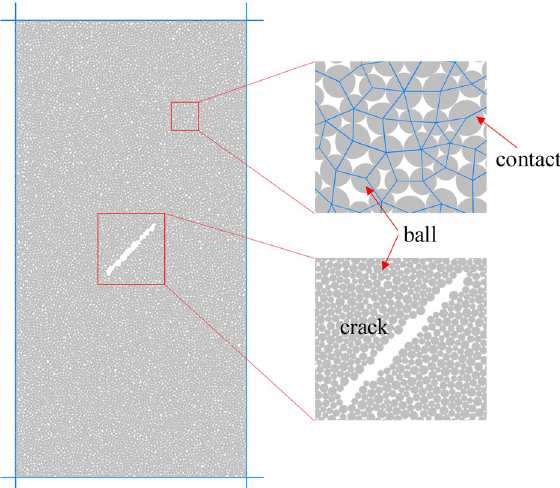
Figure 2. Numerical model of concrete with initial damage.